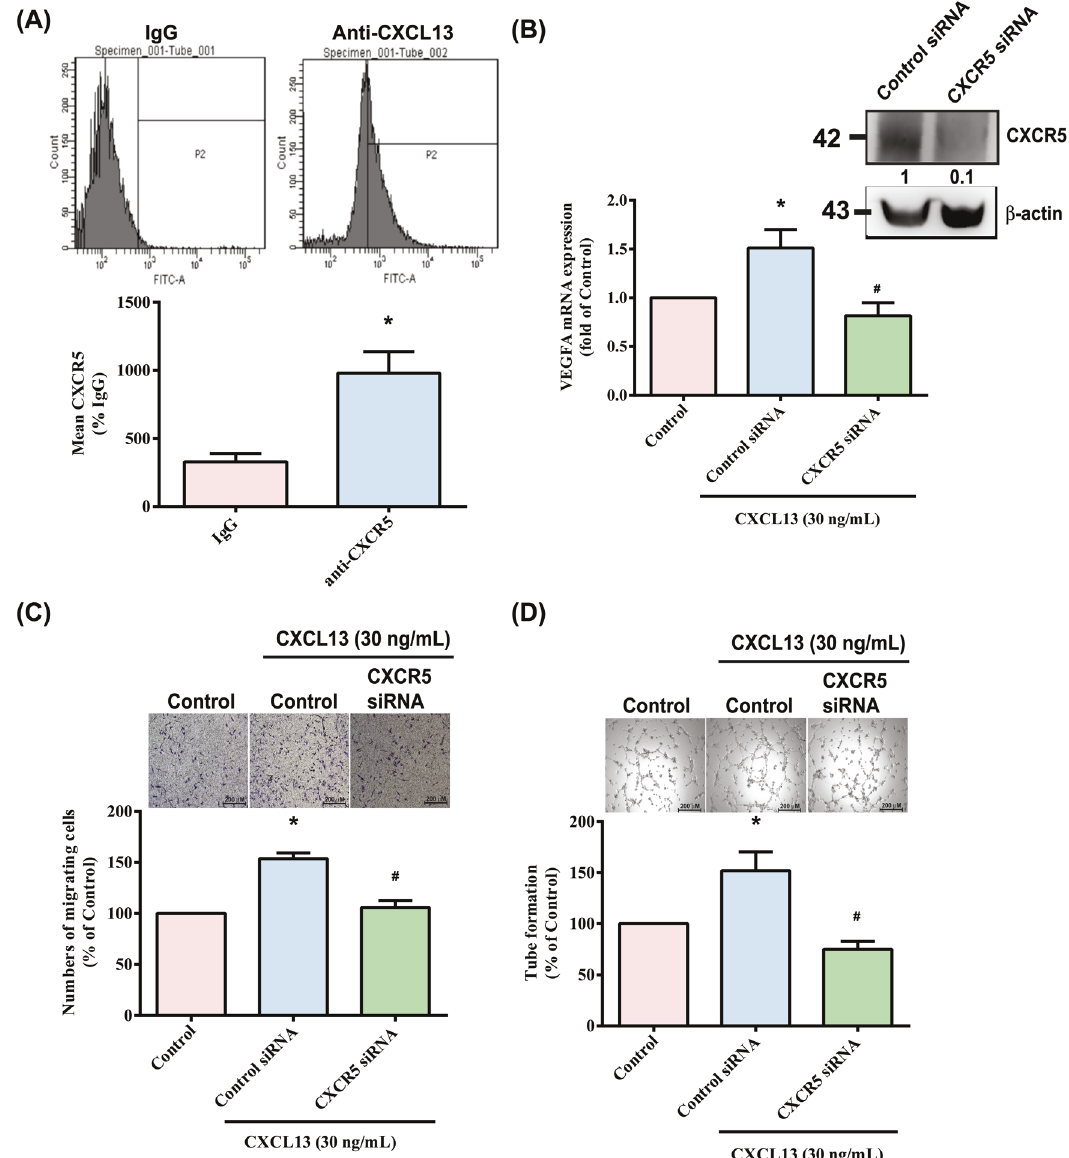
Fig. 4 The CXCR5 receptor regulates CXCL13-induced migration and tube formation in EPCs. A Cell surface expression of the CXCR5 receptor was examined by fl ow cytometry ( n = 4). EPCs were transfected with CXCR5 siRNA, the CXCR5, and β -actin for examination by Western blot ( B ; upper panel) ( n = 3). EPCs were transfected with CXCR5 siRNA before being stimulated with CXCL13. VEGF expression was examined by qPCR ( B ; lower panel) ( n = 6), and EPC cell migration ( n = 5) and tube formation were measured ( n = 5) ( C & D ). * p < 0.05 versus the control group; # p < 0.05 versus the CXCL13-treated